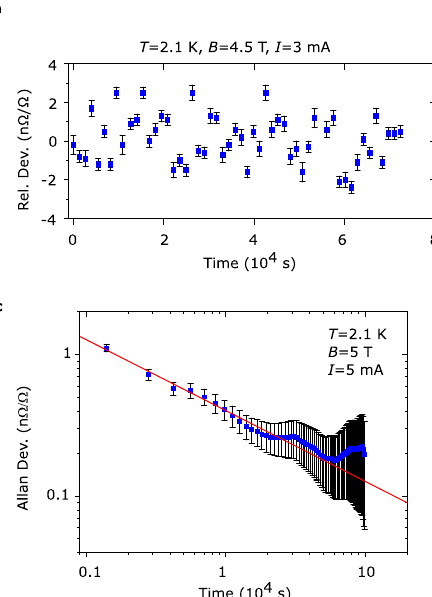
density. These measurements reveal that there is no signi fi cant deviation over the measured fl ux density range. c Allan deviation follows 1/ τ 1/2 (red line), where τ is elapsed measurement time, which indicates that white noise dominates and limits the measurement uncertainty to 0.2n Ω / Ω . At longer averaging times the Allan deviationnolongerdecreasesduetotheonsetofotherdominatingsourcessuchas 1/fnoiseandthermalvoltagedrift.The errorbarsareestimated relative errors(see Methods). d Histogram of the data which produced the means shown in b . Each count represents one 20min long measurement series. The distribution is normal, and the solid line is a Gaussian fi t which shows that the unweighted mean lies around 0.1n Ω / Ω